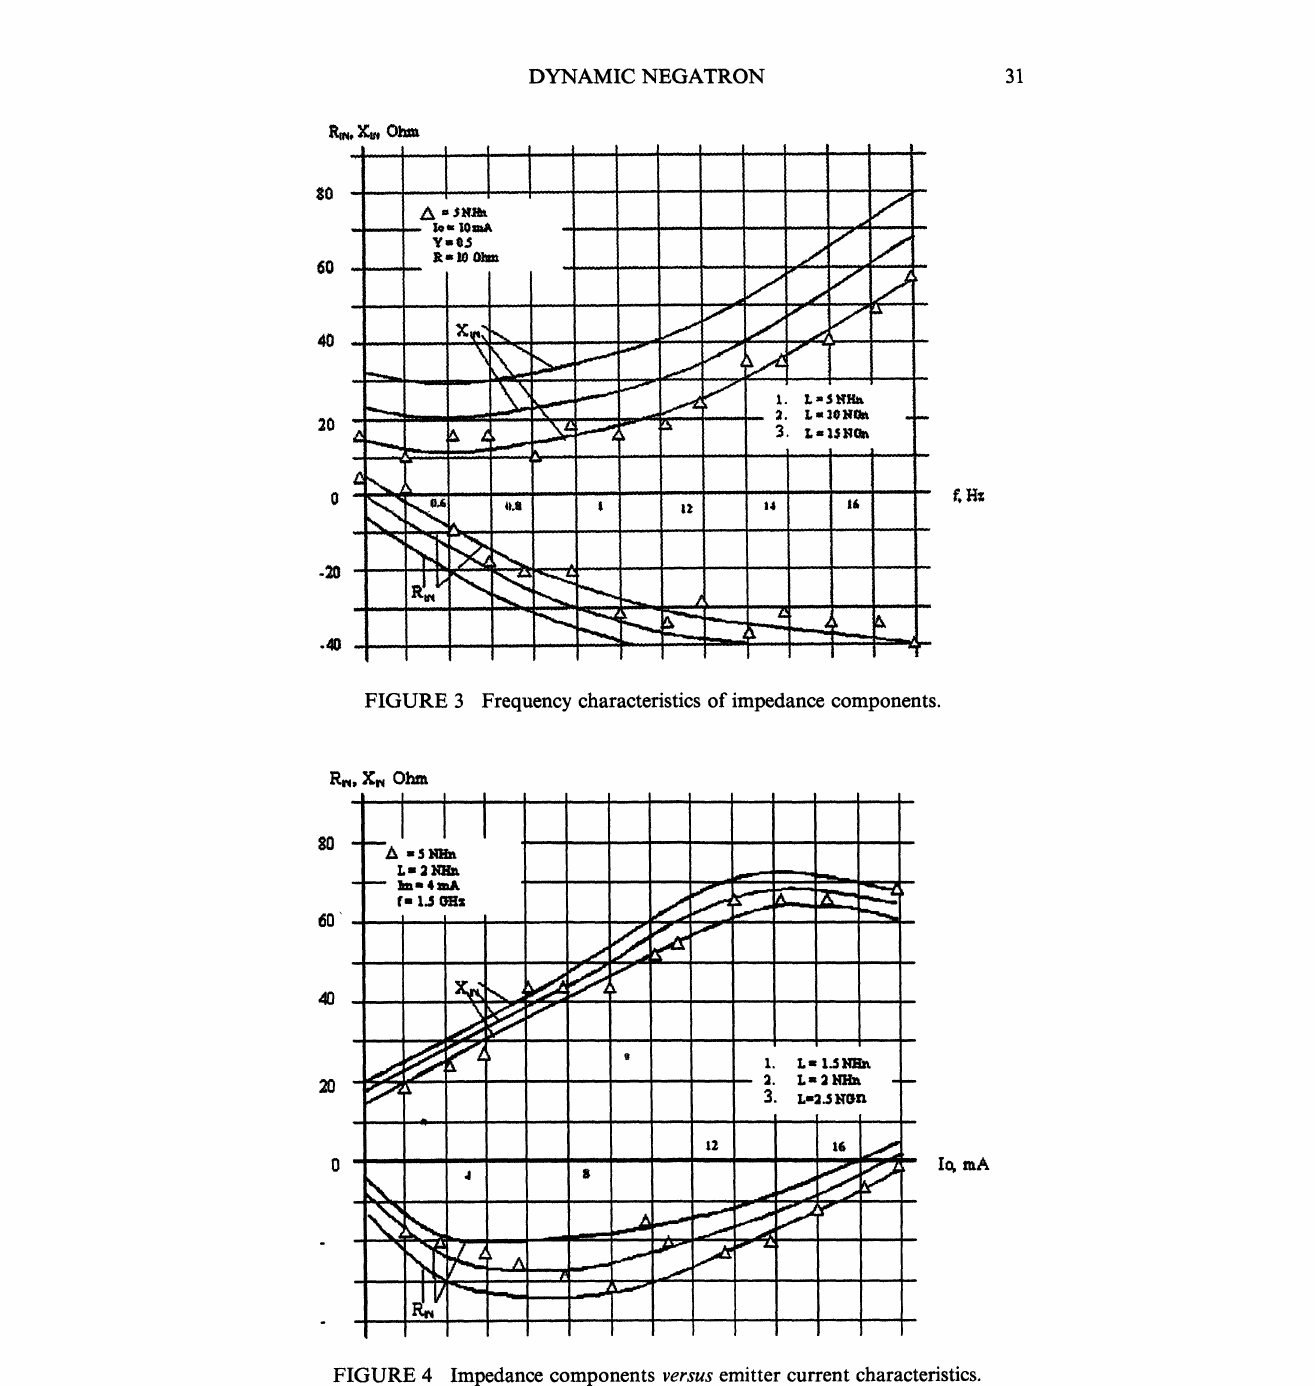
FIGURE 4 Impedance components versus emitter current